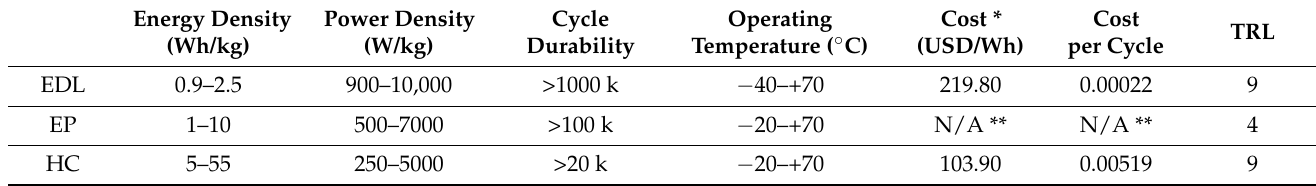
Table 4. Comparison of ultra-capacitor technology, adapted from [131–134].